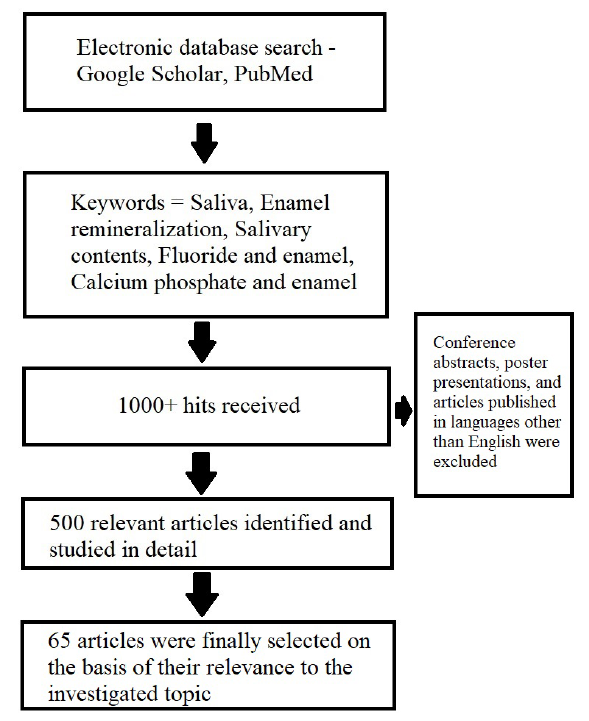
Figure 1. Flow chart depicting search strategy included in this